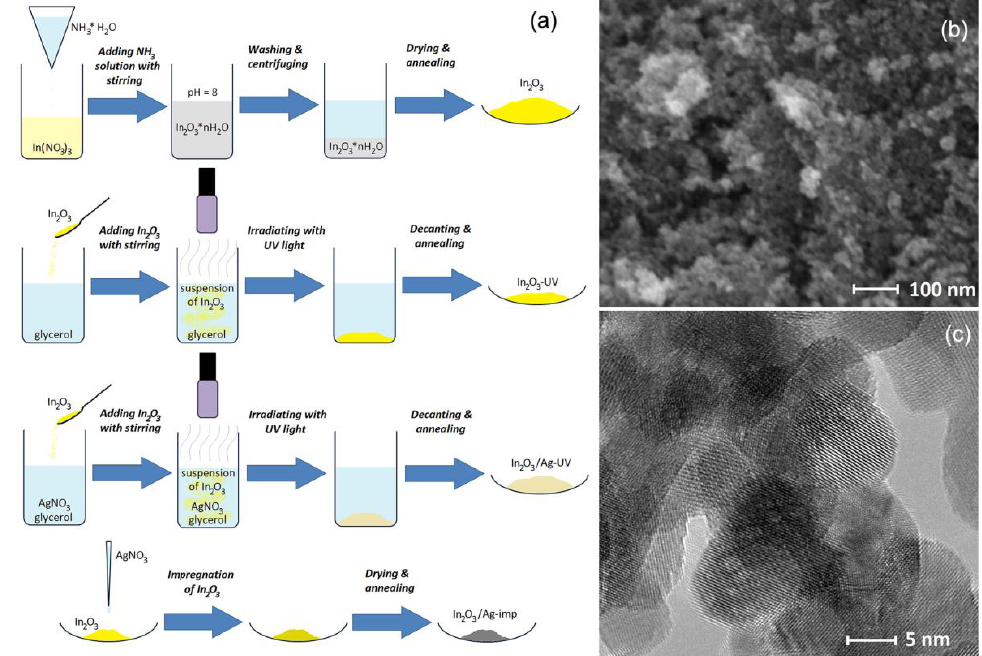
Figure 1. ( a ) Scheme of synthesis of the In 2 O 3 samples and In 2 O 3 /Ag nanocomposites. SEM ( b ) and TEM ( c ) images of In 2 O 3